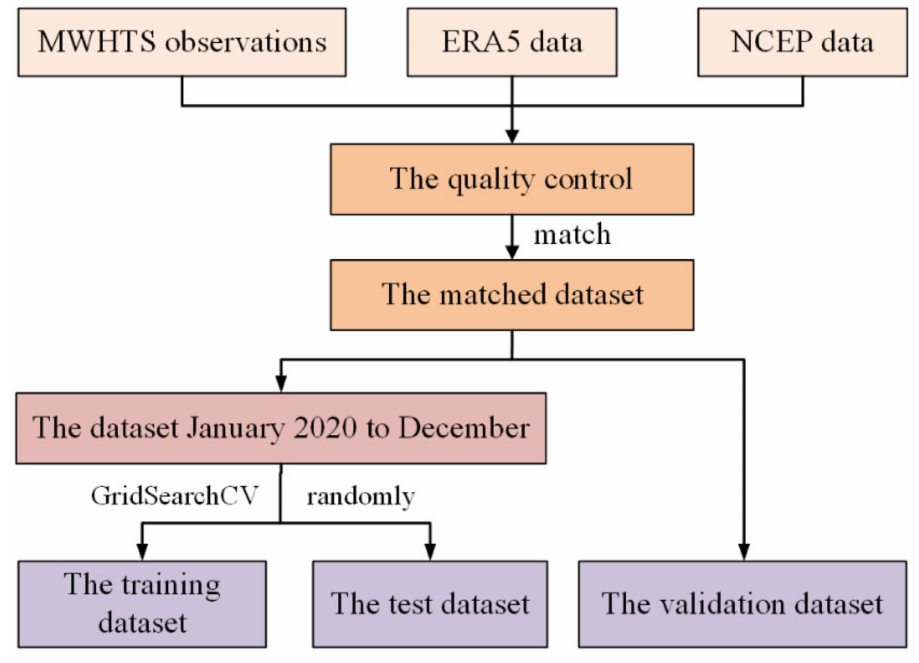
Figure 1. The schematic of the data preprocessing